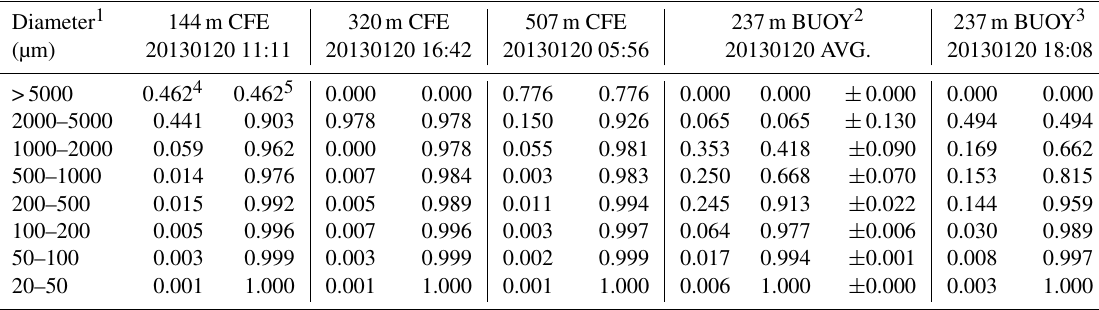
1 Diameter is equivalent circular diameter of particle with the same area. 2 Averages (excluding 18:08 data) for BUOY data; third column ( ± ) is SD of cumulative data. 3 Currents below 3cms − 1 for 60min. 4 Fraction of total volume attenuance for indicated size interval. 5 Normalized cumulative volume attenuance for particles greater than lower limit of size interval.